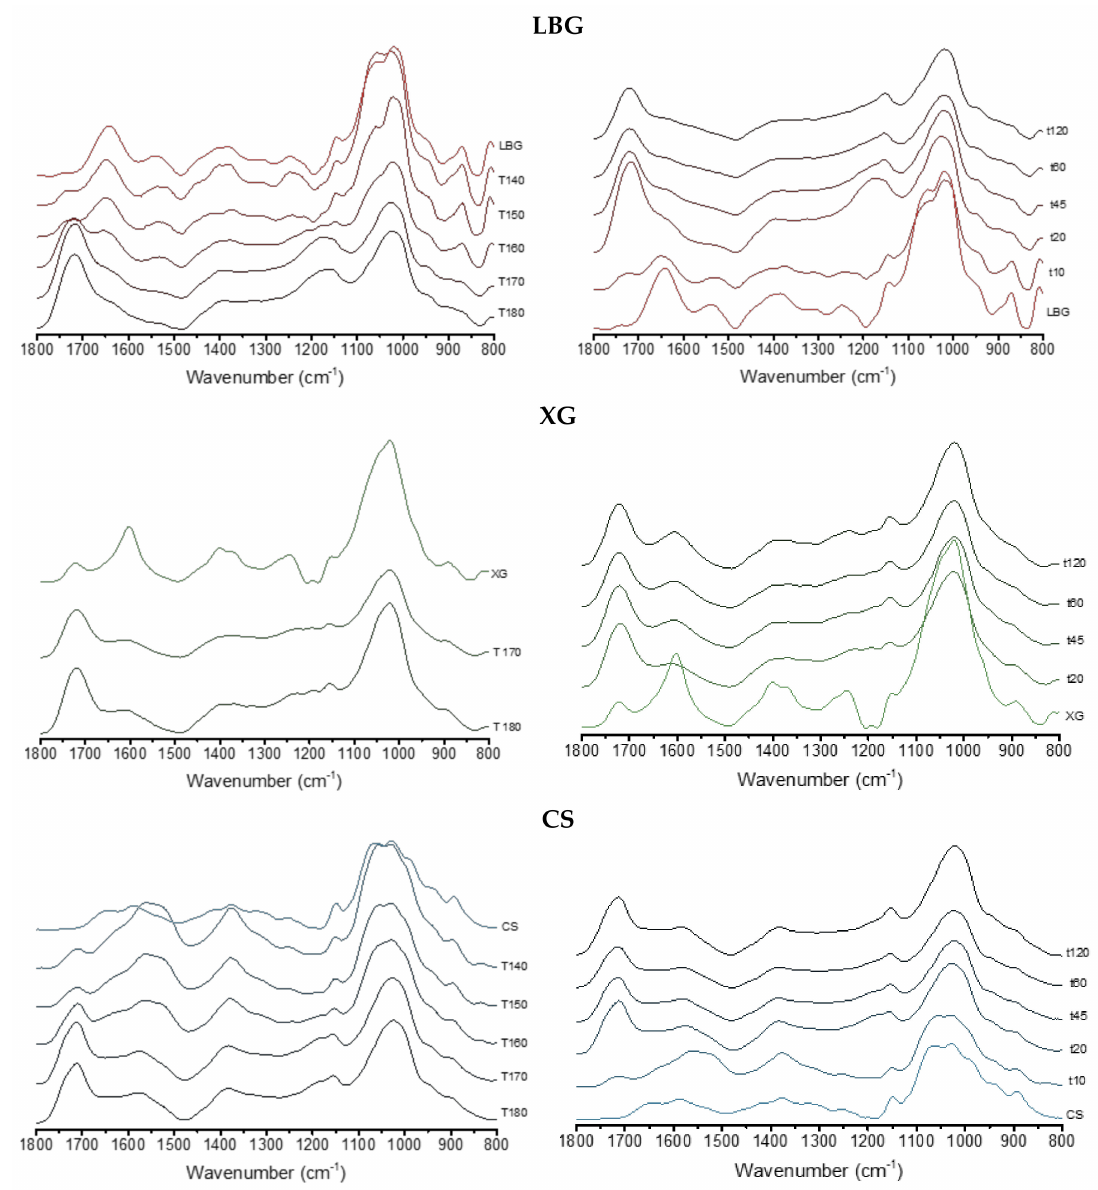
Figure 2. Infrared spectra in the 1800–600 cm − 1 region of pure LBG, XG and CS, and the products of the crosslinking reaction with β -CD and citric acid at di ff erent temperatures ( left ) and times ( right ). In the case of xanthan gum, the presence of carboxylic acid groups in its structure complicates − 1 the analysis of the 1800–1500 cm spectral region. The pure polysaccharide shows two peaks here: − 1 a more intense one located at 1600 cm , corresponding to the carboxylate groups, and a less intense − 1 one at ca. 1725 cm due to its acid groups. For the xanthan / cyclodextrin networks, the new carbonyl − 1 band at 1740 cm , characteristic of the crosslinked ester groups, overcomes the vibration mode at that location and increases in the same way as for LBG crosslinked products (see Figure